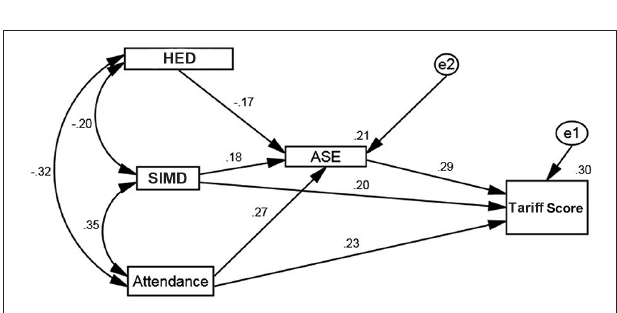
FIGURE 5 | Final, most parsimonious, path